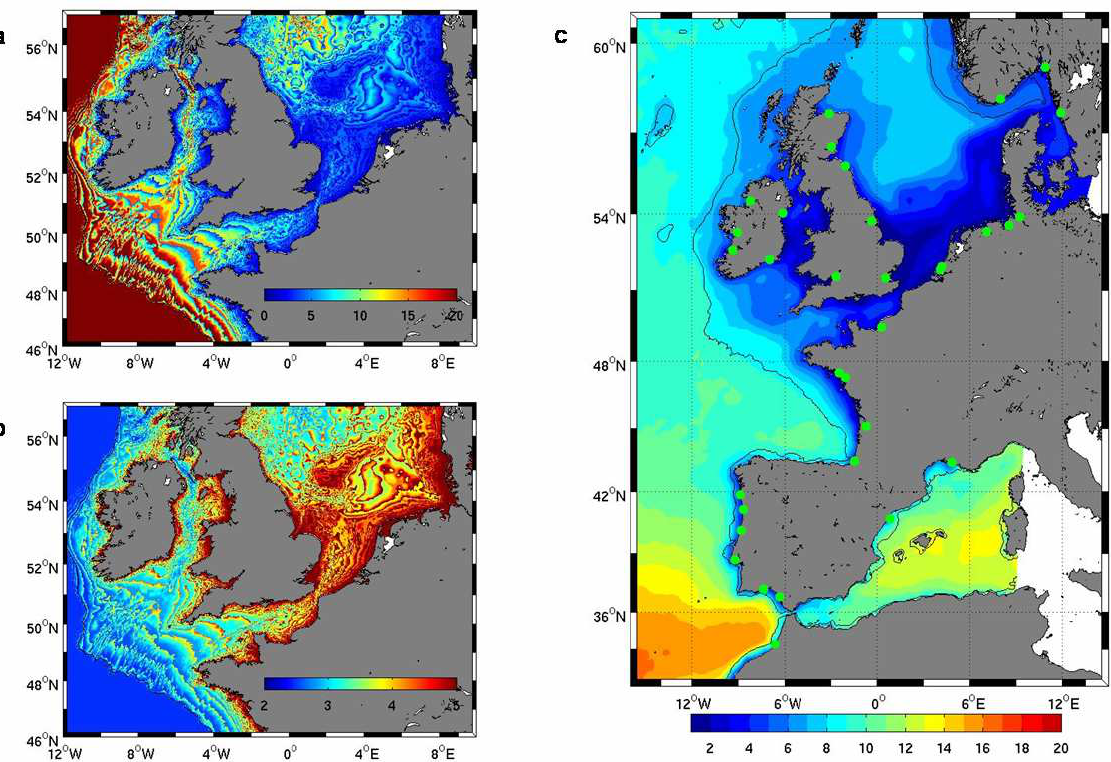
Fig. 2. (a) Partial bottom cell thickness on continental shelves (m). (b) Bottom drag coefficient Cd according to Eq. (5). (c) Annual clima- tological PAR (photosynthetically active radiation) attenuation depth derived from satellite observations (m). Green dots correspond to river Figure 2. a) Annual climatological PAR (Photosynthetically Attenuation Radiation) attenuation input locations. On each figure, the black thin line is the 200m depth derived from satellite observations (m). Green dots correspond to river inputs locations. b) Partial bottom cell thickness on continental shelves (m). c) Bottom drag coefficient Cd according to equation (5). On each figure, the black thin line is the 200m isobath.